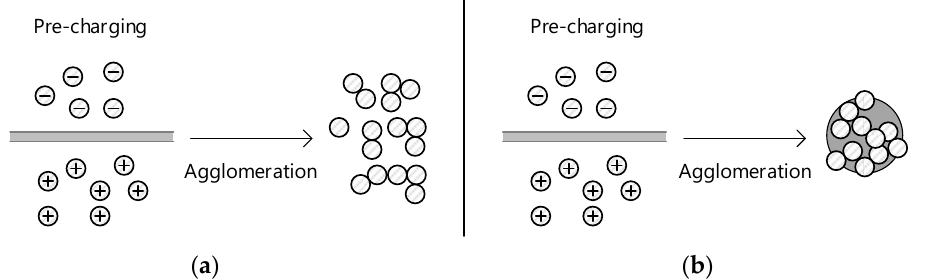
Figure 9. A simple schematic of ESS with agglomeration system.